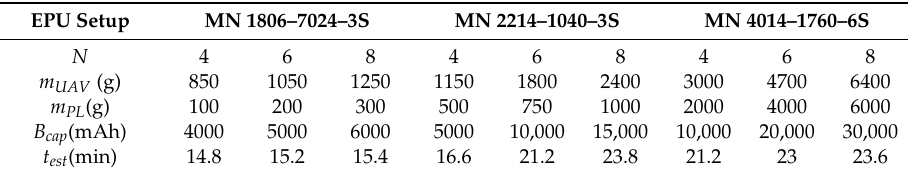
Table 2. Multirotor UAV parameters and estimated flight